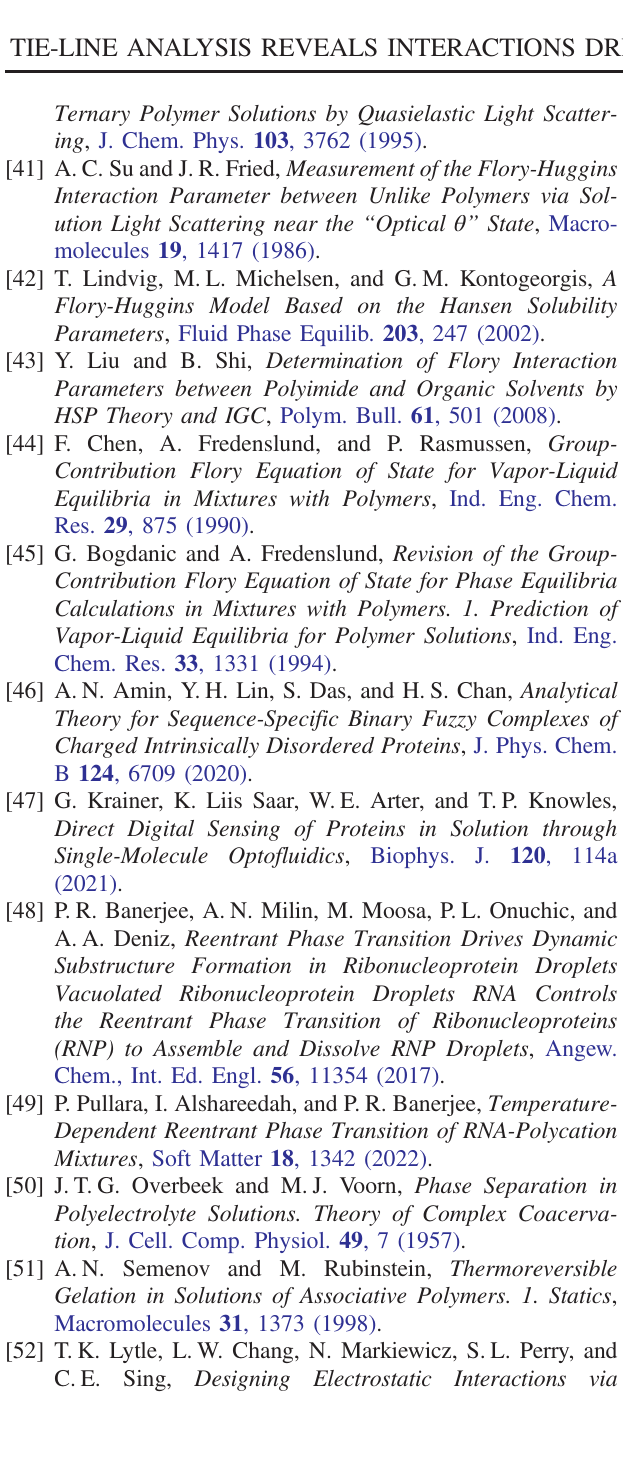
have been set right in the seventh sentence of the abstract, the penultimate sentence of Sec. I, the first and third sentences of Sec. III D, the sixth sentence of Sec. III E, and the fourth sentence of the second paragraph of Sec. V. Related changes occurred in the upper right label in Fig. 3(g), the second image and entry in second row, last column appearing in Table I, and the two entries in the last row, last two columns in Table